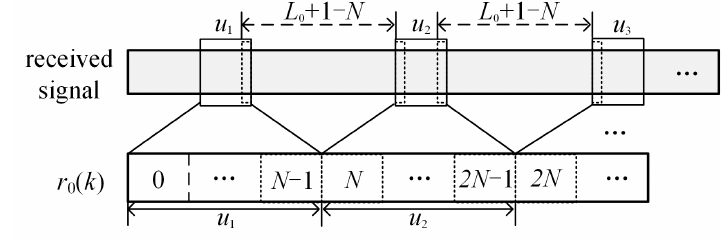
Figure 6. The discontinuity of r 0 ( k )